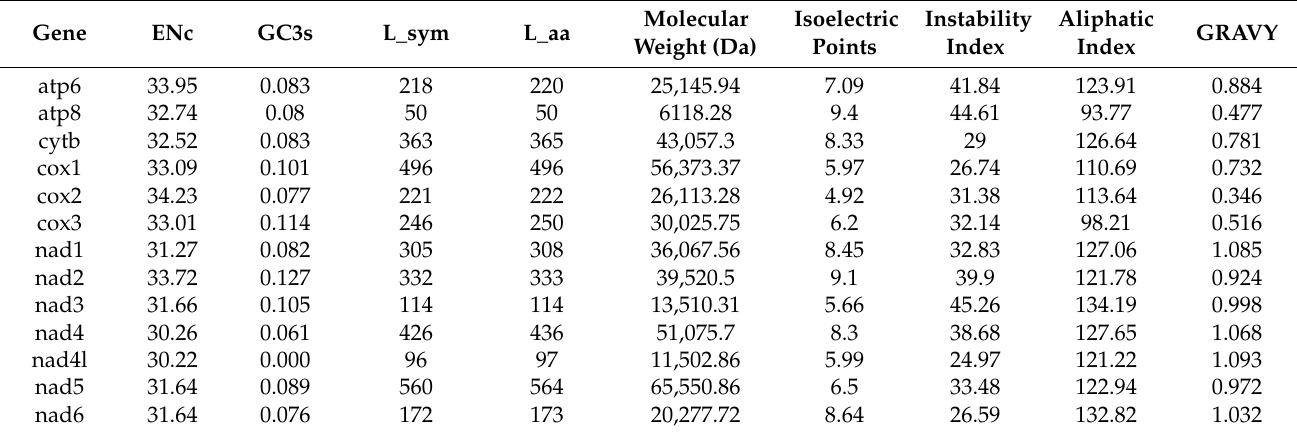
Table 3. Basic information on the protein molecules of the PCGs gene in the complete mt genome of P. casei